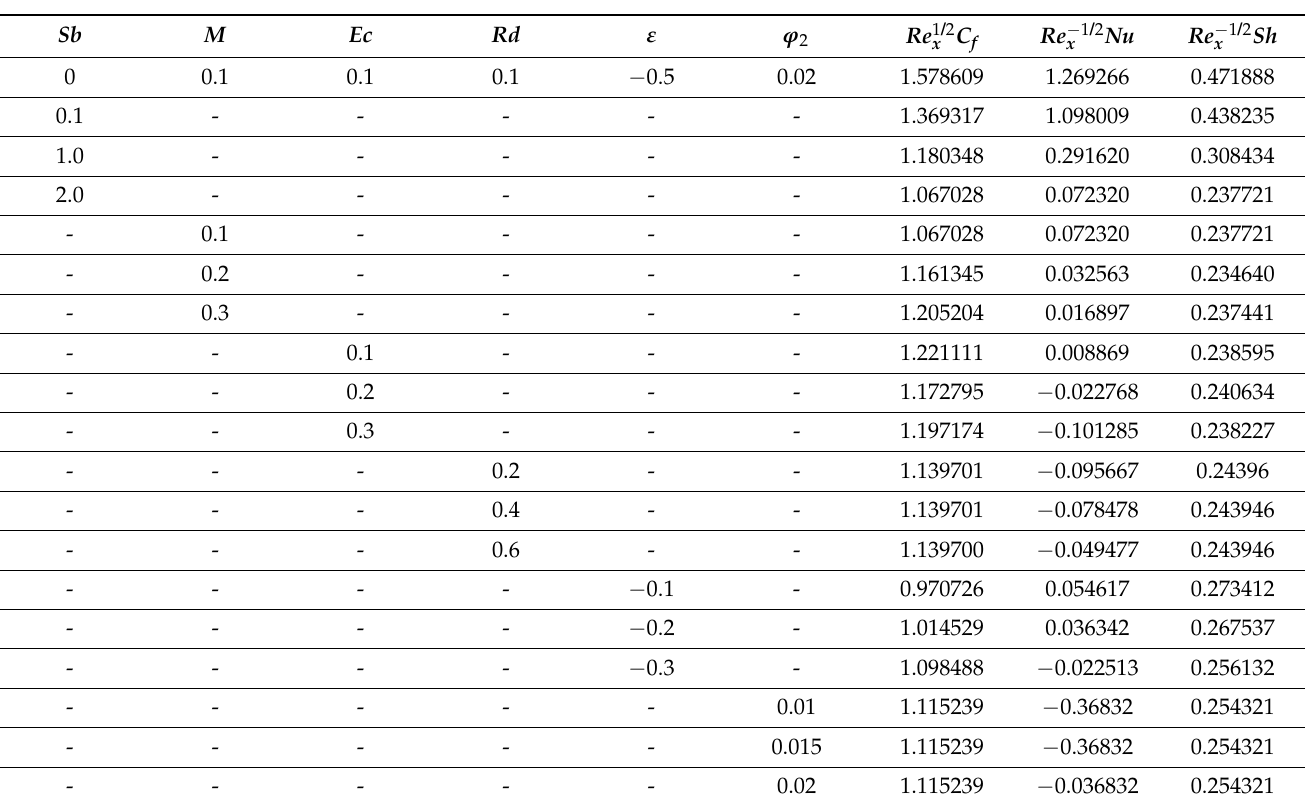
Table 4. Numerical results of C f , Nu , and Sh when ϕ 1 = 0.02 and Pr =